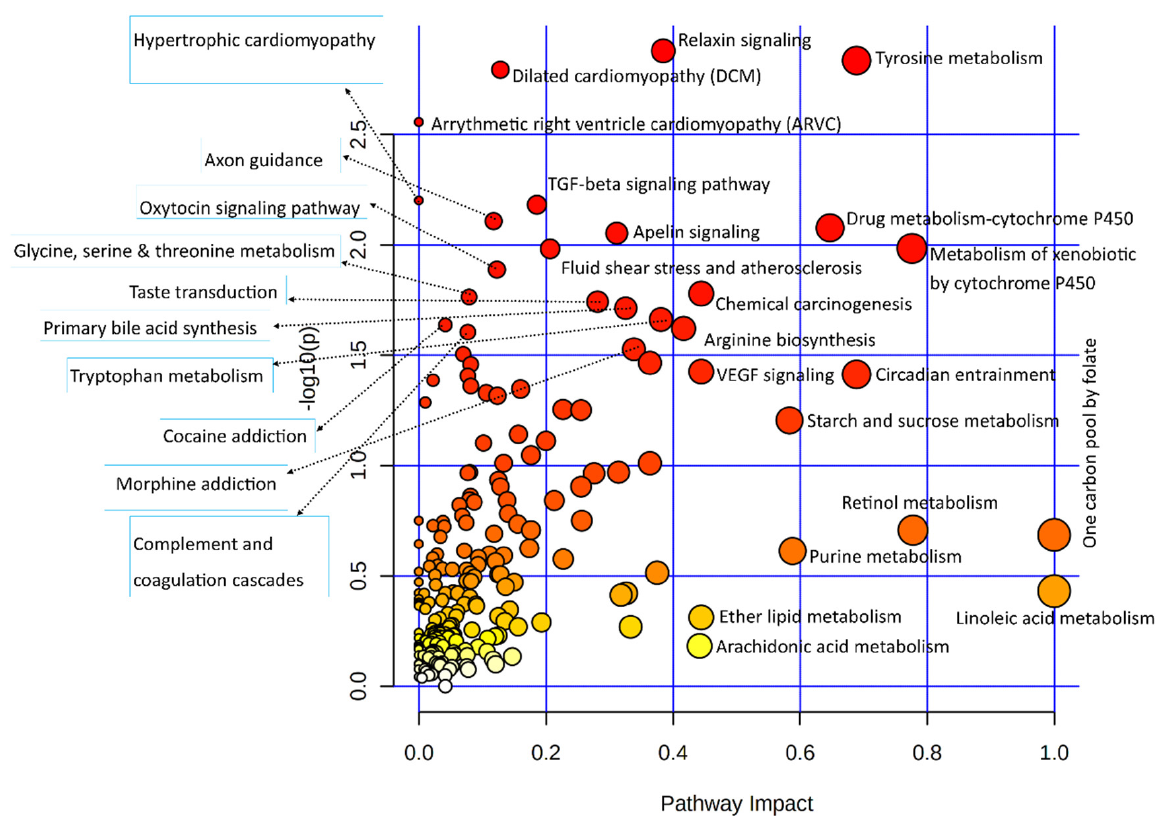
Figure 2. Dot plot illustration of the pathway enrichment of significantly differentially expressed genes used in this study. Various pathways in the upper and left quadrants are labeled. The dot sizes increase with the increasing pathway impact; color intensifies according to the y -axis.